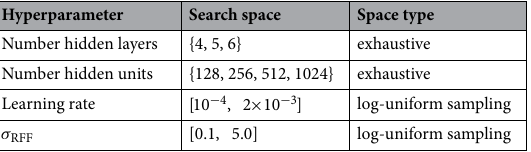
Table 5. Reduced space searched for the final tuning of hyperparameters characterising the MLP